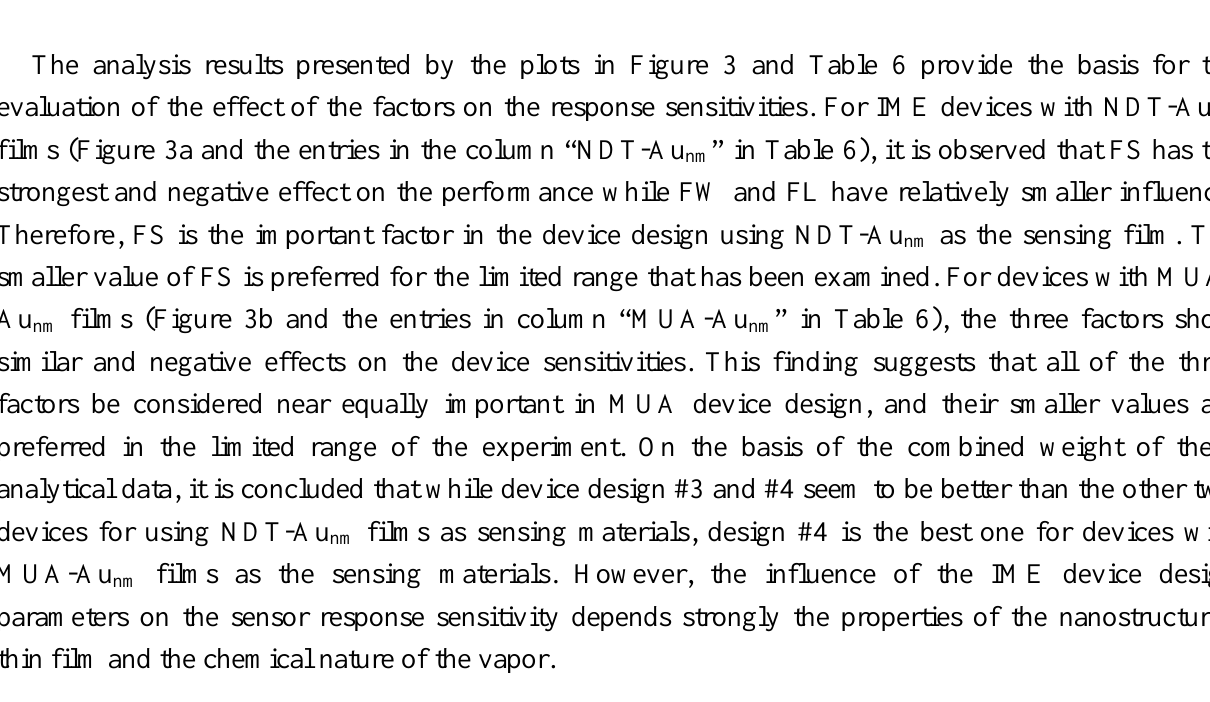
/IME, and (b) MUA-Au /IME. nm nm